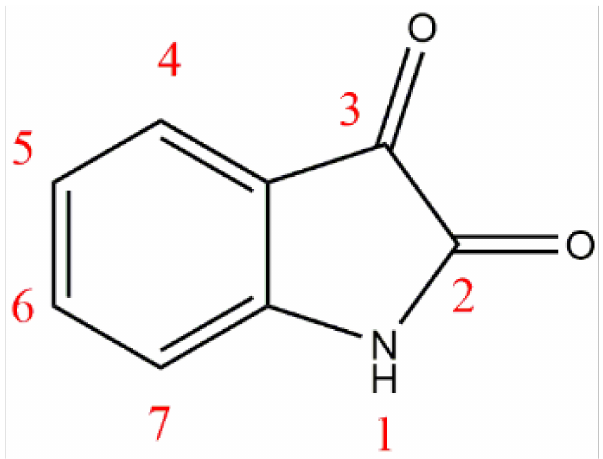
Figure 1. Structure and atom numbering in isatin